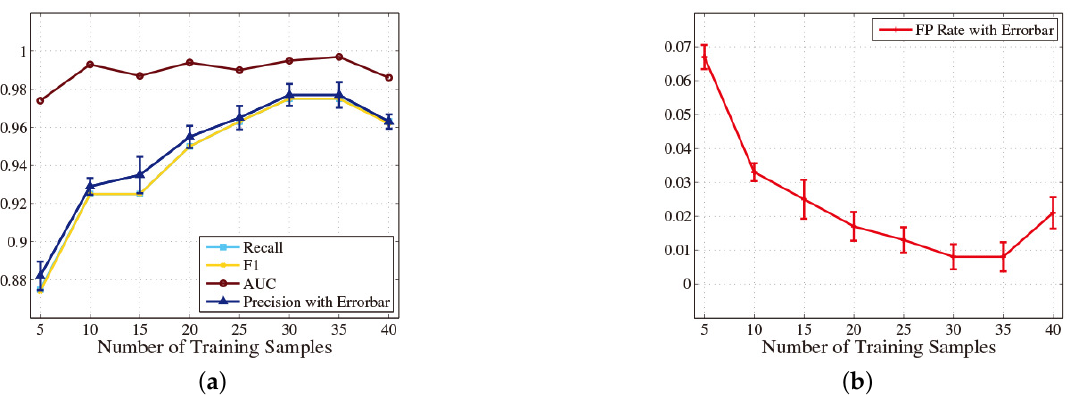
Figure 8. ( a , b ) Impact of the number of training